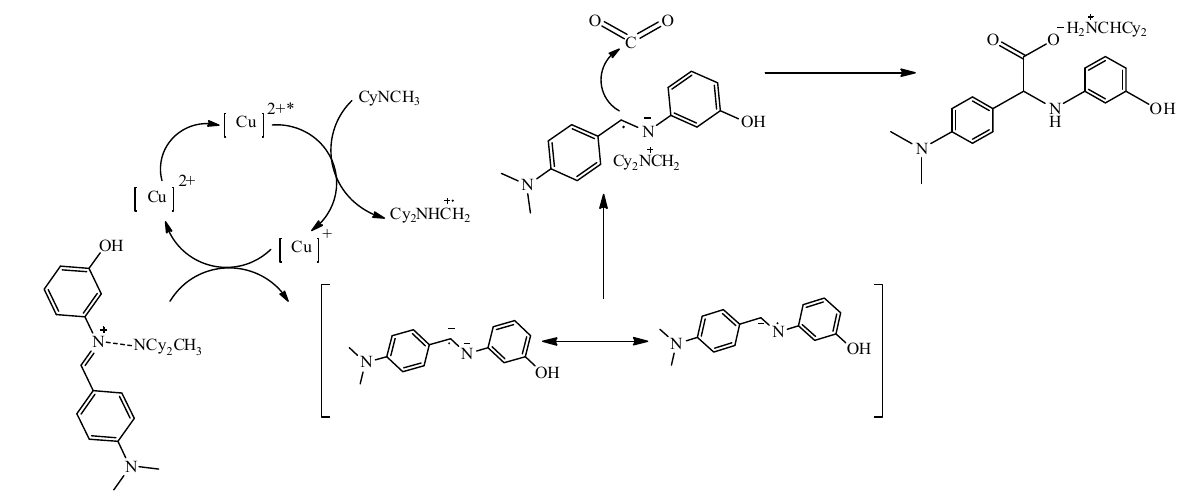
Figure 3. Plausible mechanism of Cu(II) photoredox catalysis.